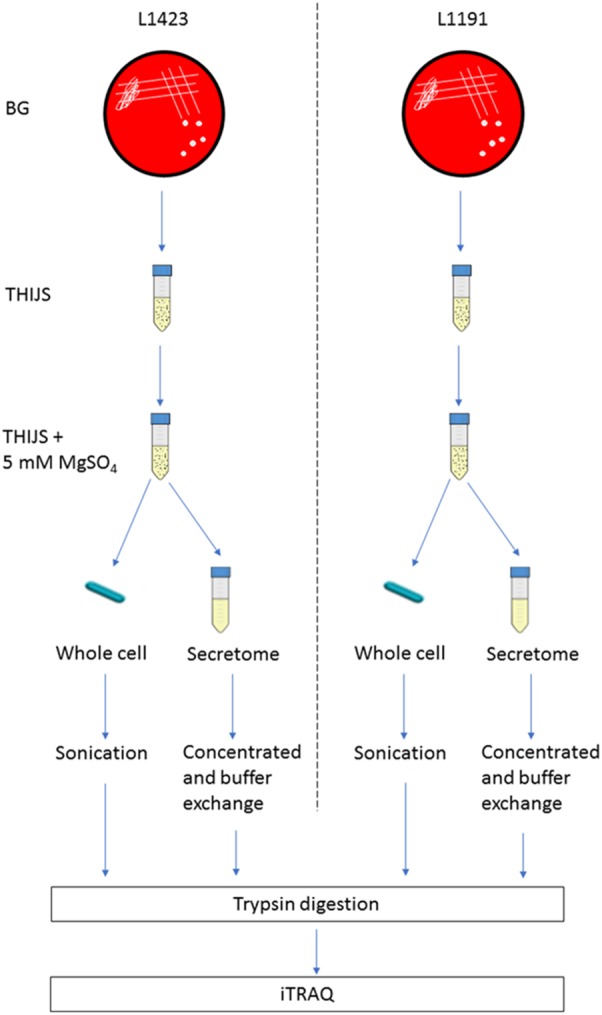
Experimental design of iTRAQ experiment. L1423 and L1191 were grown simultaneously in parallel on BG plates. Pure small, hemolytic Bvg+ colonies were then inoculated into THIJS and then into THIJS + 5 mM MgSO4. After 12 h incubation, the whole cell was sonicated and the secretome concentrated. Protein samples were then digested and labeled with iTRAQ reagents.